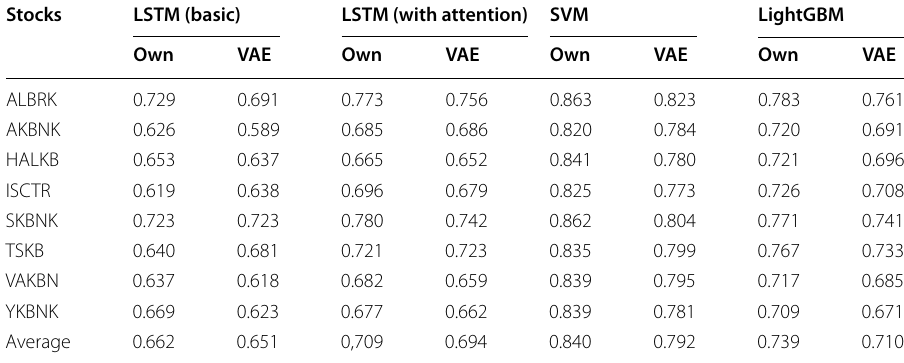
Table 9 Training accuracy rates of own and VAE-reduced stock features Stocks